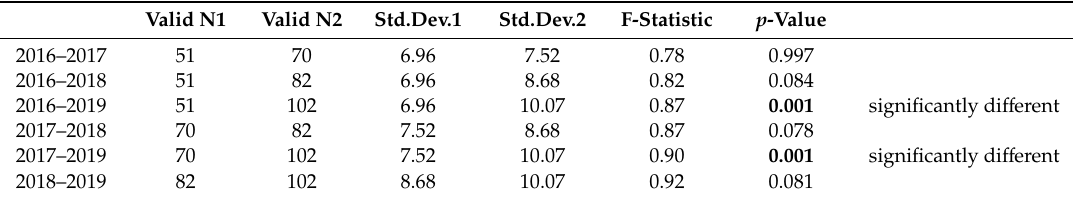
Table 3. The proof of the equality of variance.